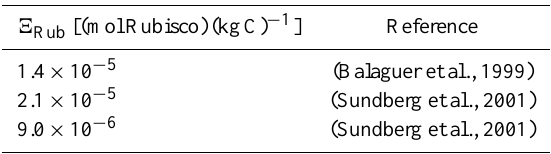
Table B6. Overview of the Rubisco content 4 Rub of lichens and